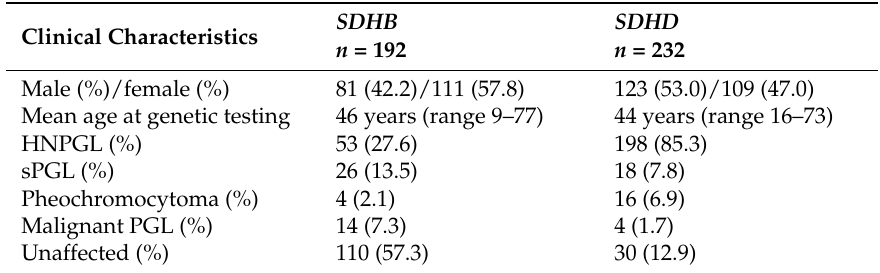
Table 1. Clinical characteristics of carriers of pathogenic variants in succinate dehydrogenase subunits B and D ( SDHB and SDHD